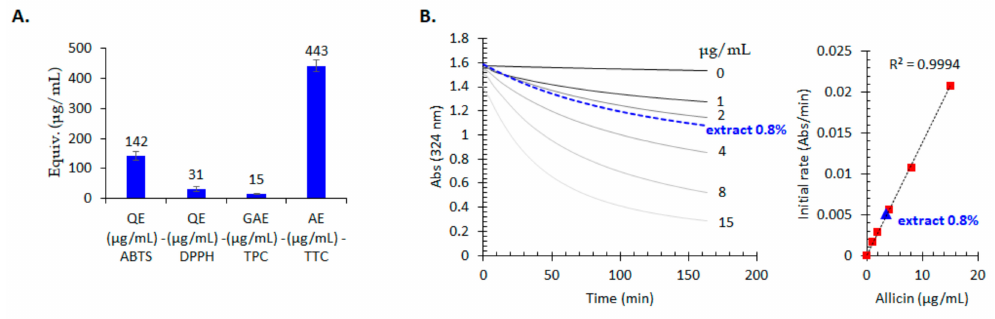
Figure 7. ( A ) In vitro antioxidant activity evaluated using ABTS and DPPH scavenging assays and expressed as quercetin equivalents (QE), total phenolic content (TPC) determined using Folin-Ciolalteau reagent and expressed as gallic acid equivalents (GAE) and total thiosulfinate content (TTC) and expressed in allicin equivalents (AE), n = 3, error bars are standard deviations ( B ) Kinetic determination of total thiosulfinate content of the studied A. sativum extract (0.8%) using Miron et al. [22] kinetic assay and the allicin standards (0–15 µ g / mL) and the corresponding calibration